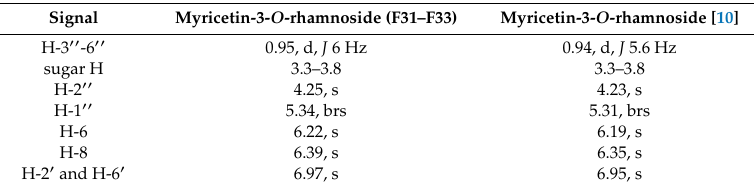
Table 2. Chemical shifts ( 1 H (ppm), 350 MHz, methanol- d 4 ) and measurement conditions of the isolated myricetin-3- O -rhamnoside compared to data from literature [11].